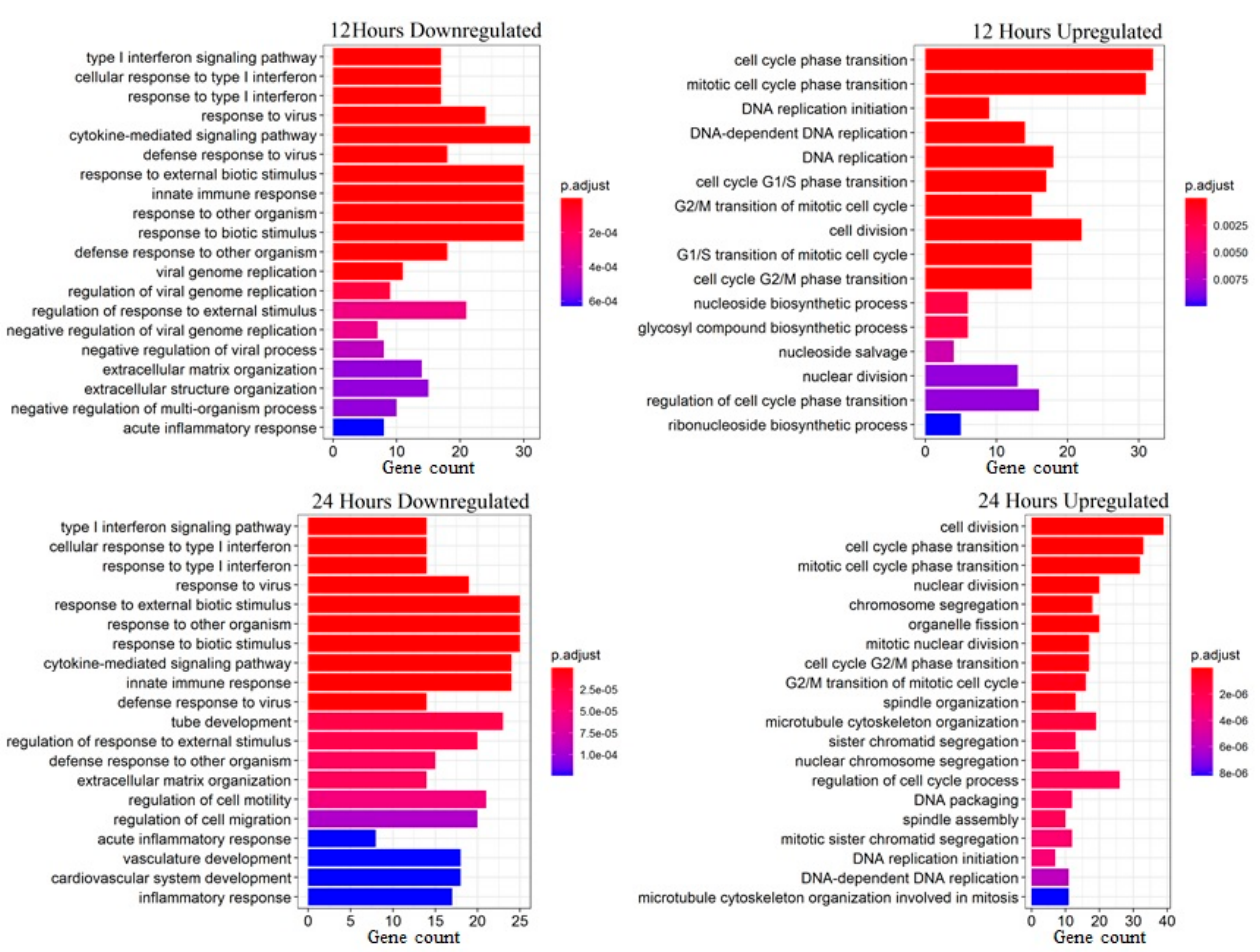
Figure 2. Biological processes associated with differentially expressed genes in human adipose-derived MSCs after 12 and 24 h of PDGF-BB treatment.